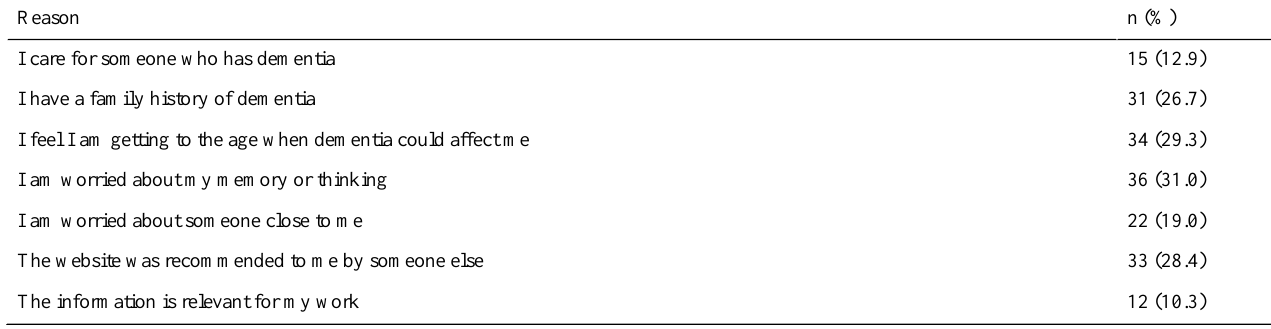
Table 3. Proportion of respondents who selected the given reasons for their interest in the website (N=116).